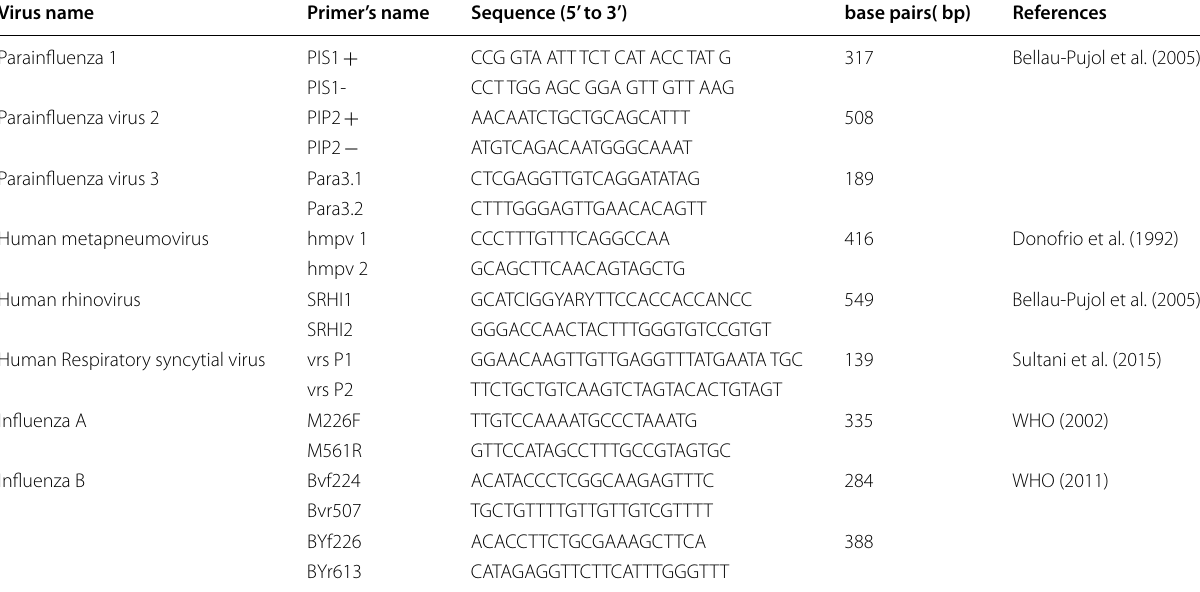
Table 1 Primers list for detection of the target